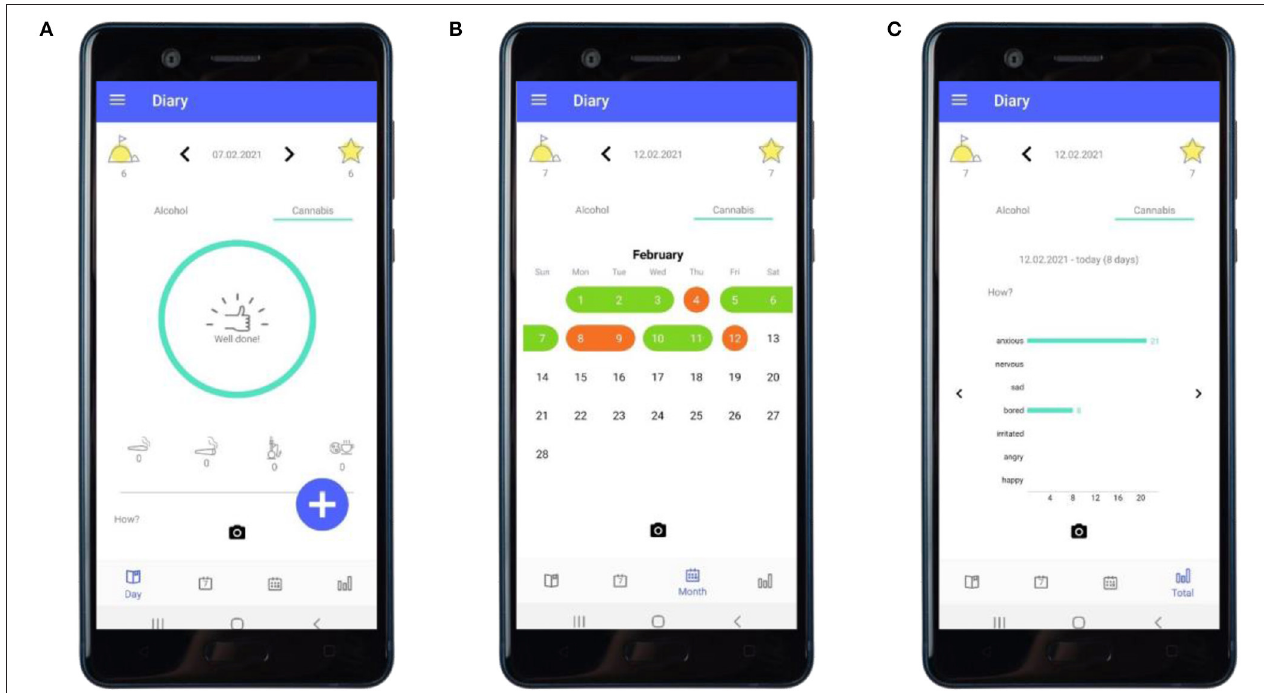
FIGURE 3 | “Diary”: feedback about consumption. (A) Feedback following an entry of a day not having used cannabis. (B) The calendar providing an overview of a user’s recorded use of cannabis. (C) The statistics section providing an overview of the user’s recorded mood while having used cannabis.